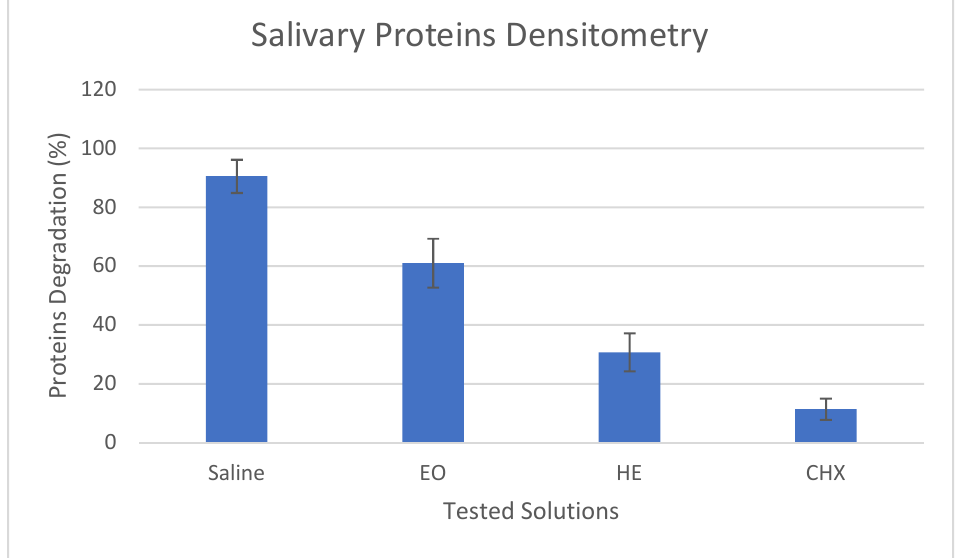
Figure 4. The mean results (±SD) of the salivary proteins degradation measured using SDS PAGE densitometry, for the various tested solutions: Saline, essential oils (EO), herbal extracts (HE), and chlorhexidine (CHX) formulations as indicated.